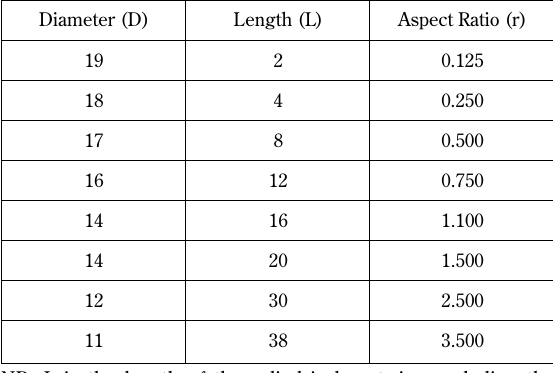
Table 2 Geometric parameters of the spherocylinders